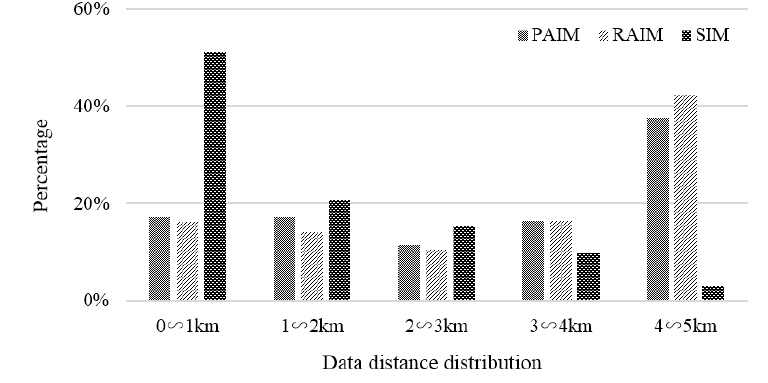
Figure 11. Comparison of data distance